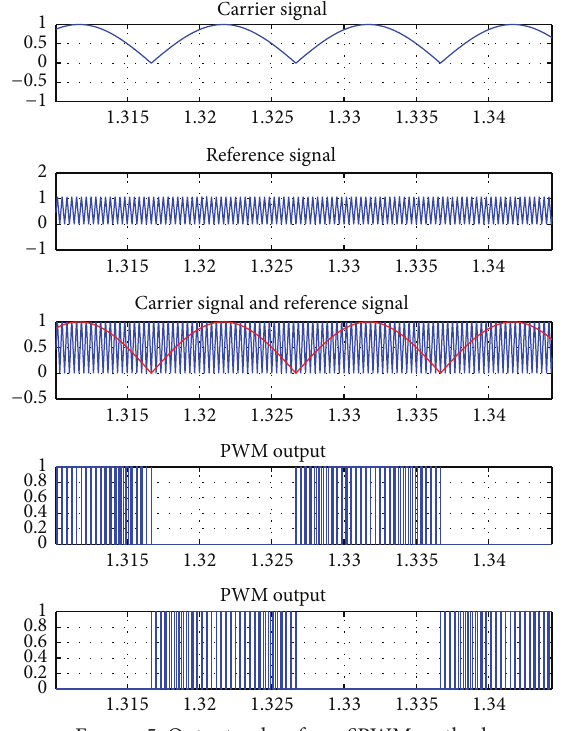
Figure 5: Output pulses from SPWM